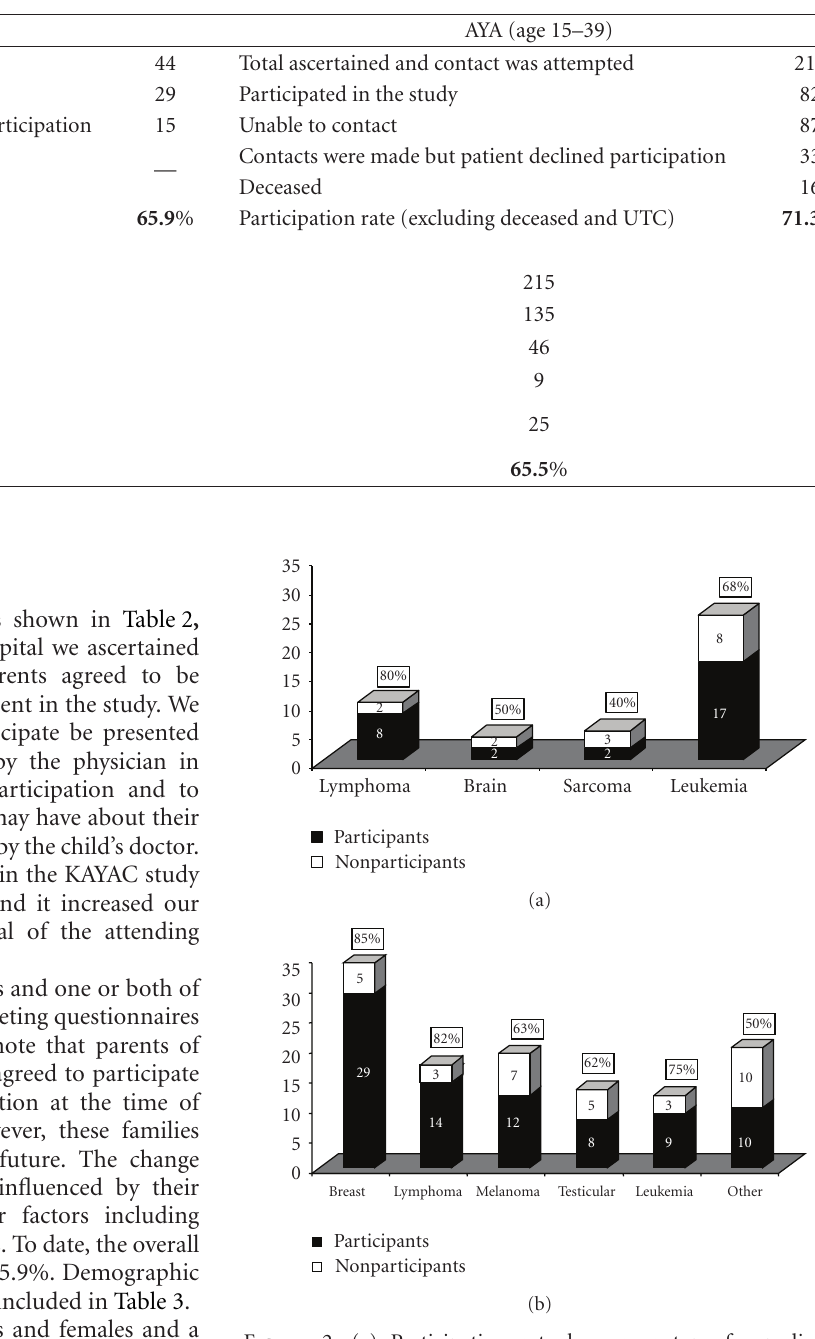
Figure 2: (a) Participation rate by cancer type for pediatric population (age 0–14). (b) Participation rate by cancer type for AYA population (age